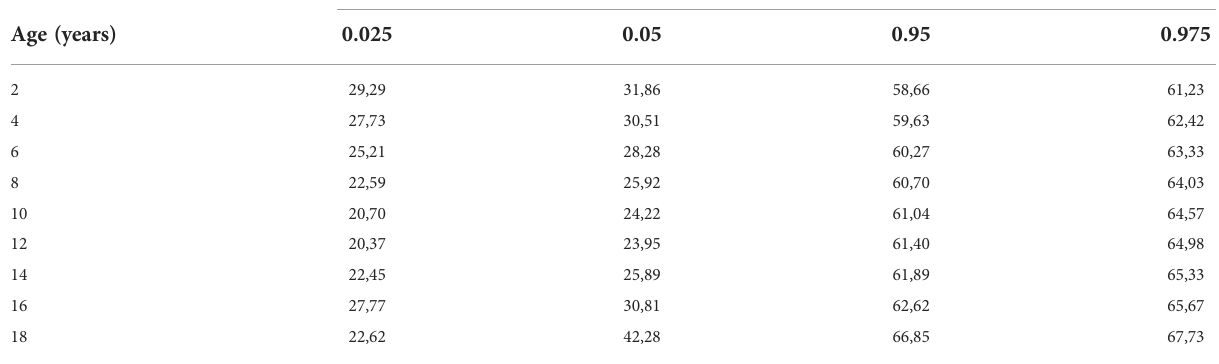
TABLE 4 The centiles calculated for different ages are shown.